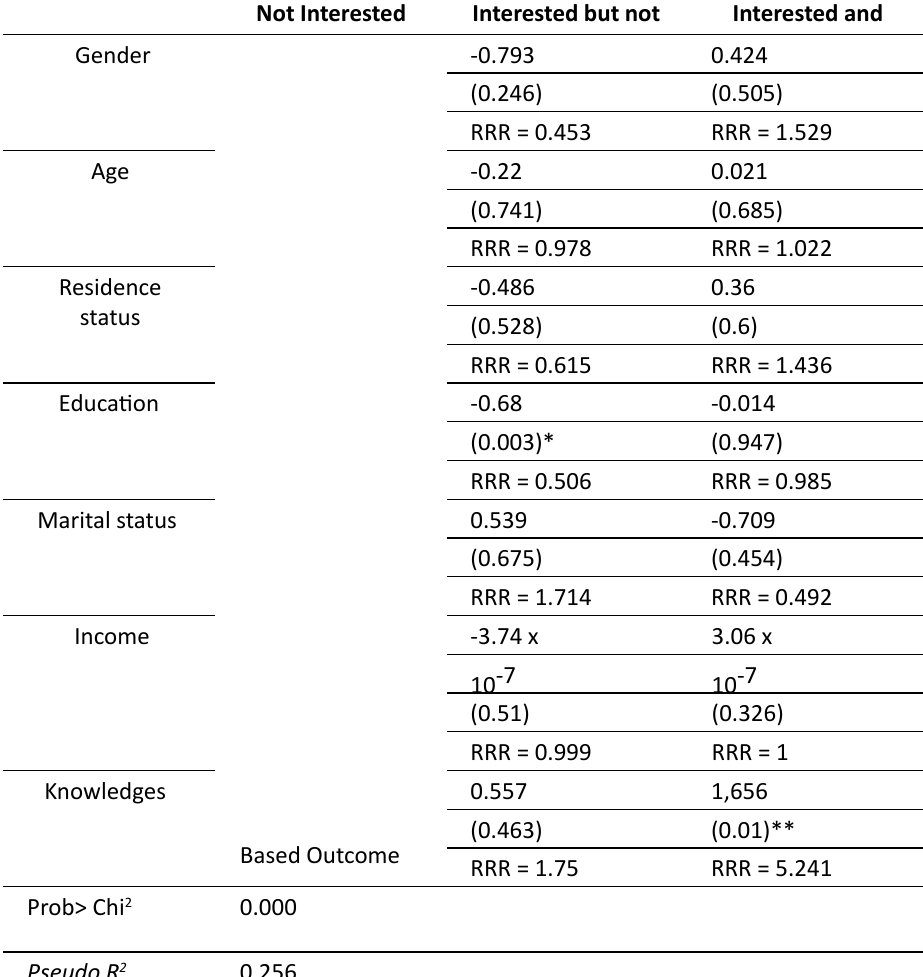
Table 3: Scenario 1: Results of Multinomial Logit Model Estimation Not Interested Interested but not Interested